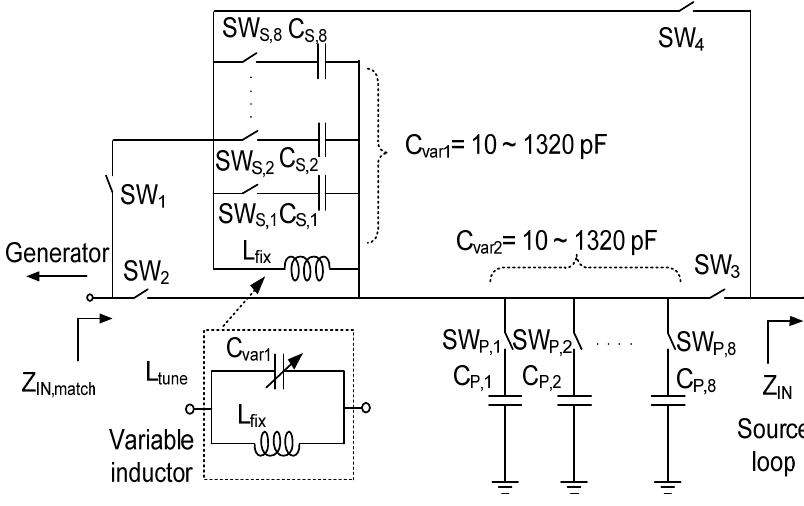
Figure 5. Schematic of tunable matching network; and circuit schematic of tunable inductor L tune is shown in the